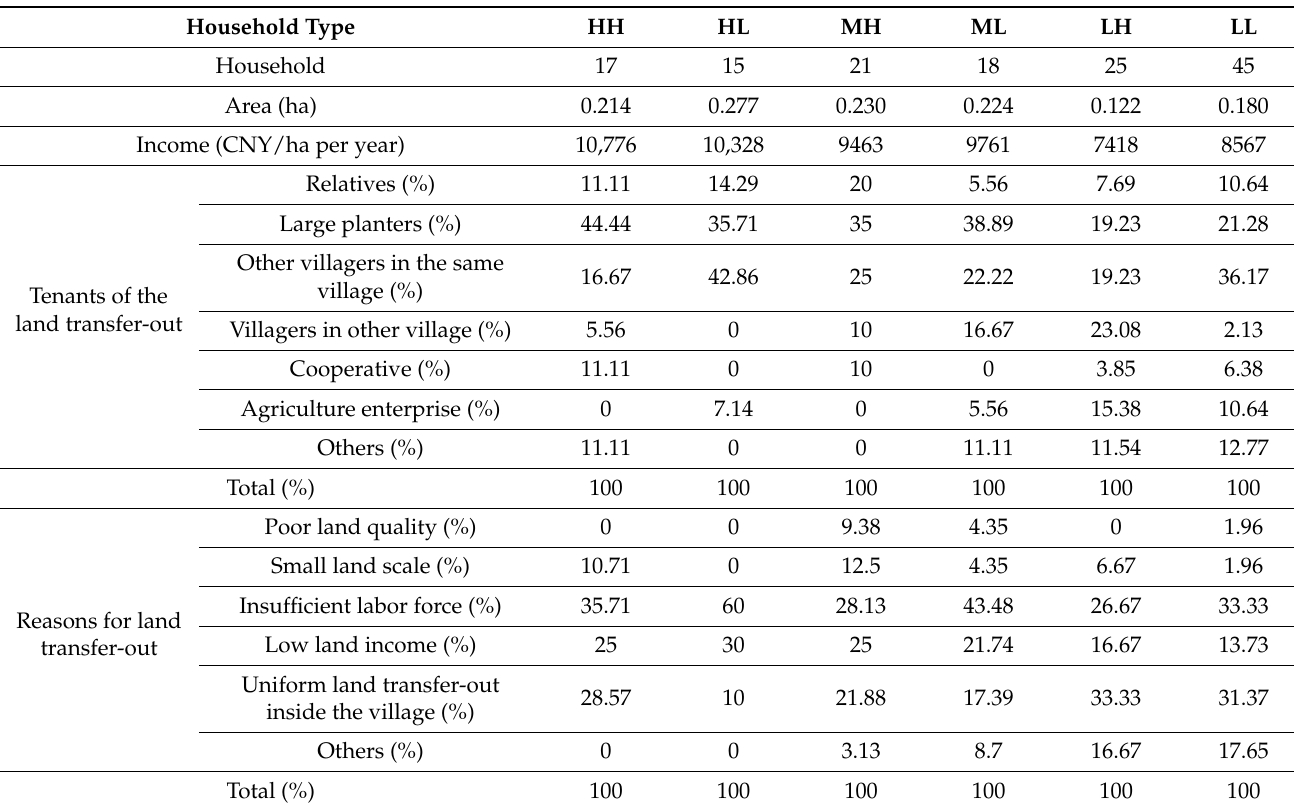
Table 9. Land transfer-out